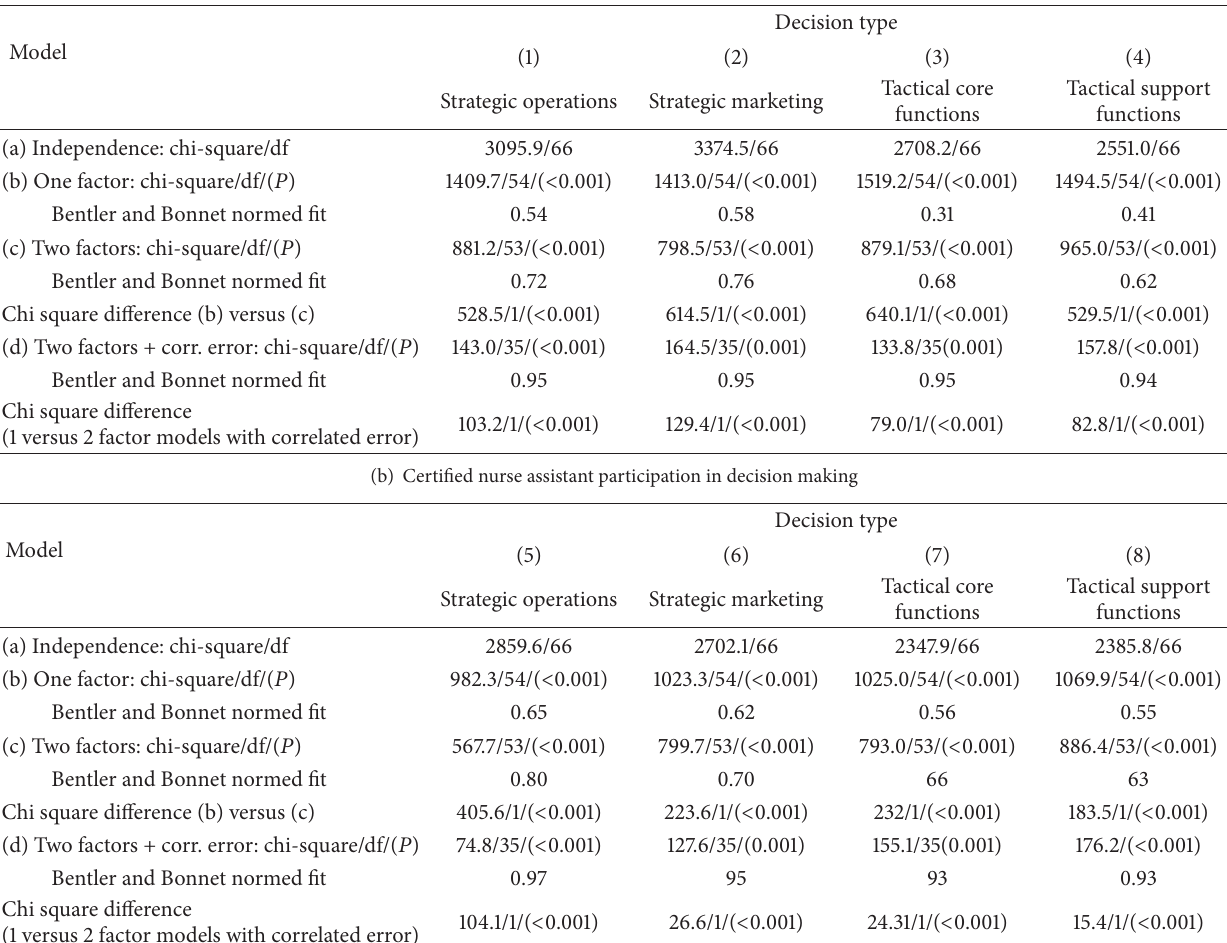
Table 3: Study II: Confirmatory factor models estimated for scope and intensity items from the PDM scales ( 𝑁 = 195